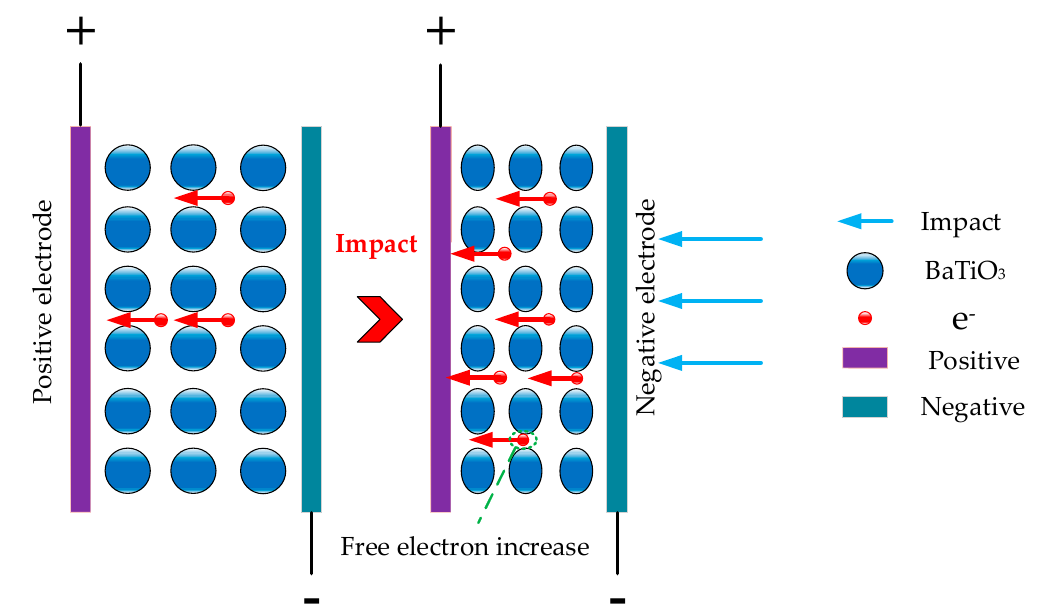
Figure 6. Schematic diagram of the leakage current increase during impact.